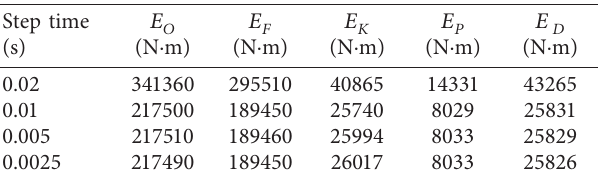
Figure 7: Comparison of time history of the energy response in different time steps, T acceleration is 0.4 g . (a) Δ t � 0.02s, (b) Δ t � 0.01s, (c) Δ t � 0.005s, and (d) Δ t � 0.0025s. Table 2: Amplitudes of energy response: the El Centro seismic wave. Table 3: Amplitudes of energy response: the TAFT seismic